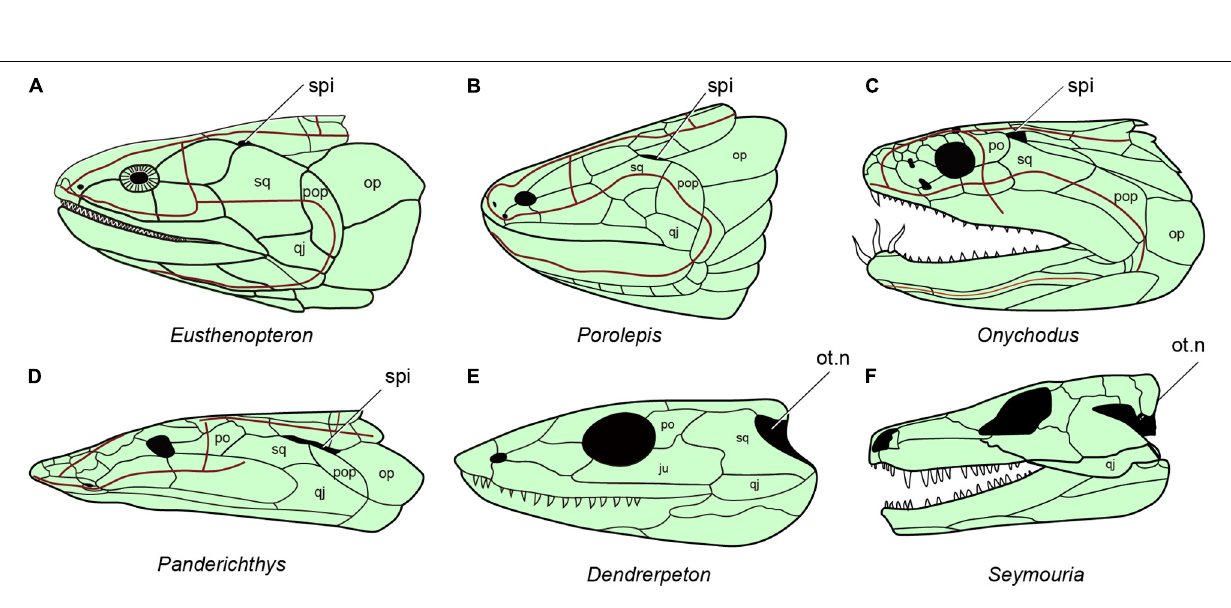
Frontiers in Ecology and Evolution |